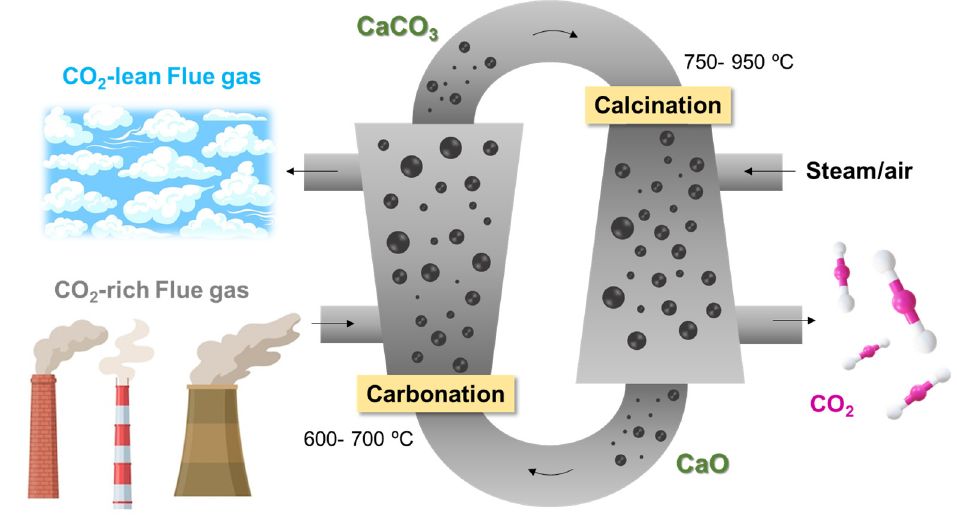
Figure 2. Schematic representation of Ca-looping CO 2 capture process.